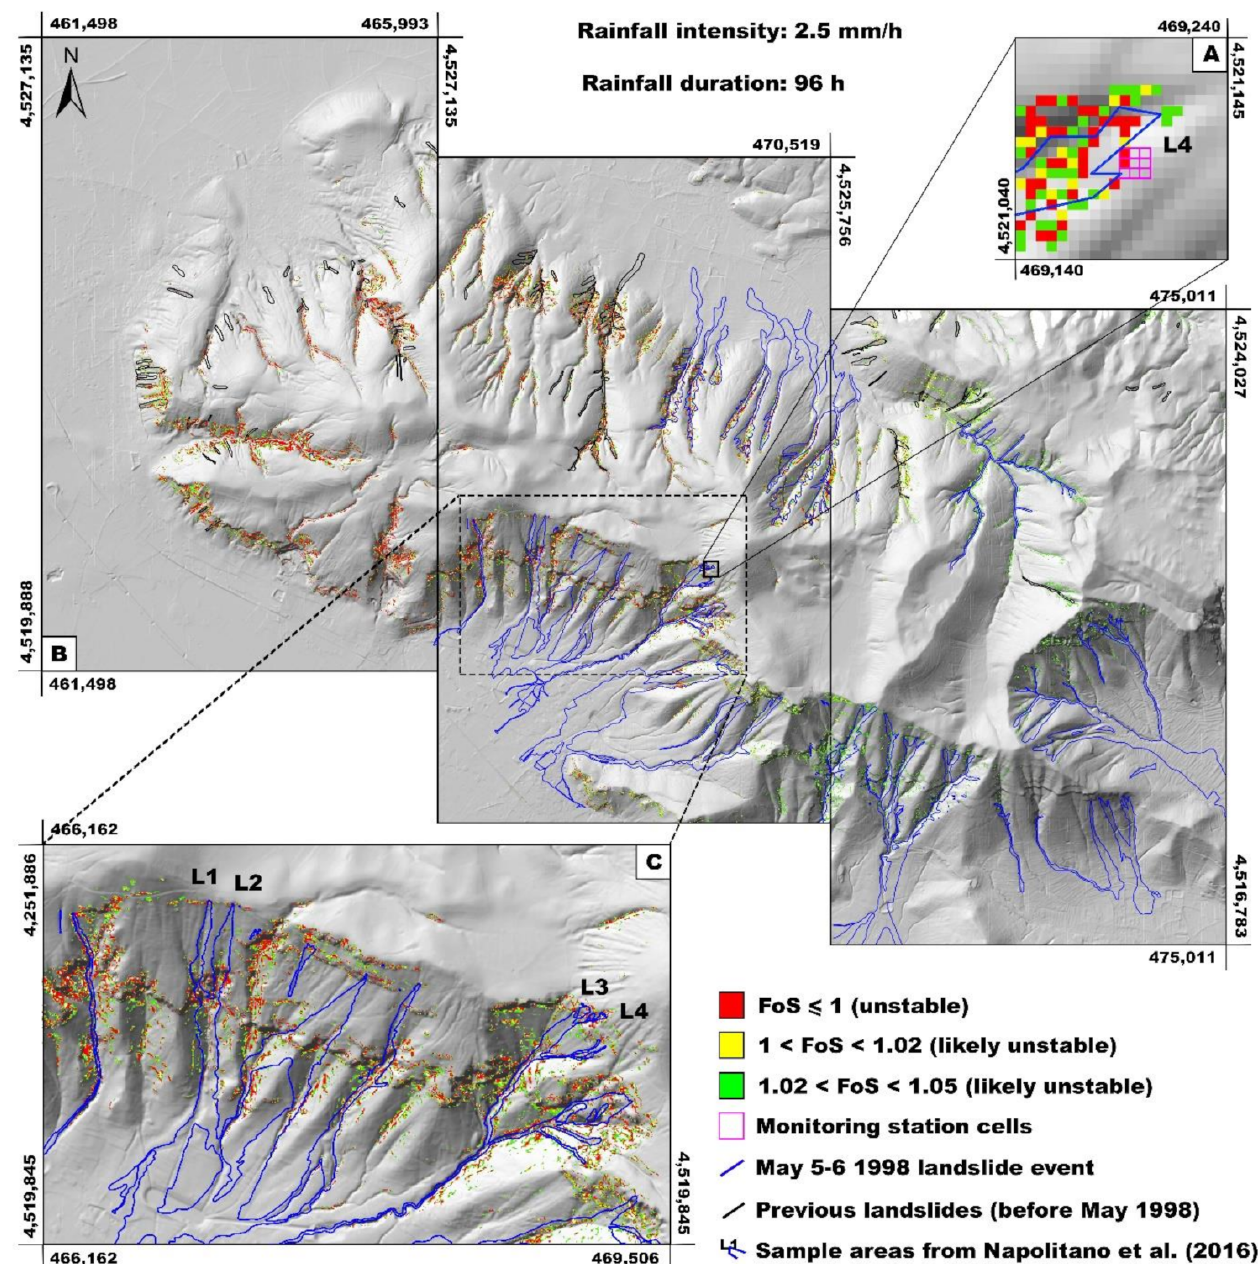
Figure 8. Distributed slope stability maps, at site-specific ( A ) and slope distributed ( B ) scales, resulting from a constant rainfall intensity of 2.5 mm/h with a duration of 96 h. Unstable and likely unstable cells were compared within sample areas ( C ) L1, L2, L3 [77], L4 and the entire Sarno Mountains landslide inventory comprising the May 1998 Sarno landslide event. Monitoring station cells used for local scale modeling and L4 threshold definition are also shown ( C ) (WGS84/UTM